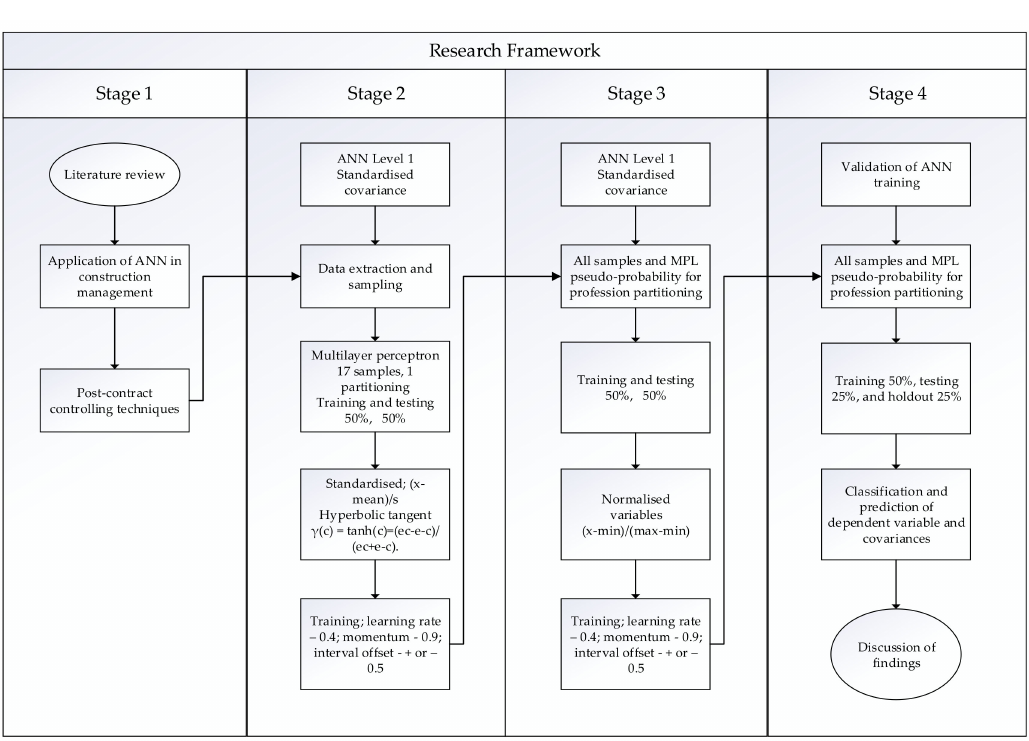
Figure 1. Research framework for ANN prediction of post-contract cost controlling techniques in building construction (Source: Authors’ compilation,